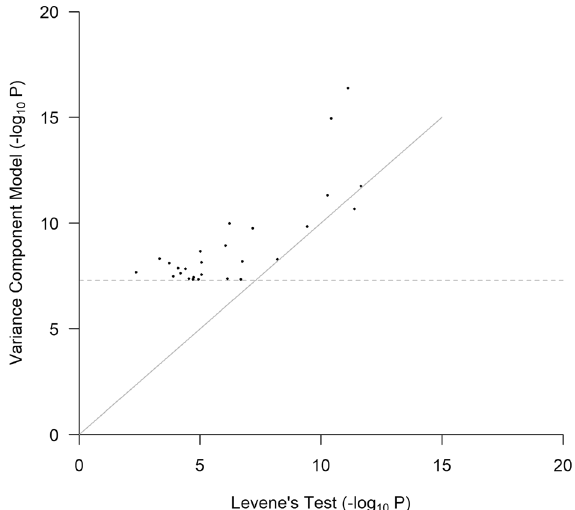
Figure 6. P values of the 27 vQTLs by Levene’s test. The dashed line represents the genome-wide significance level (P = 5 × 10 −8